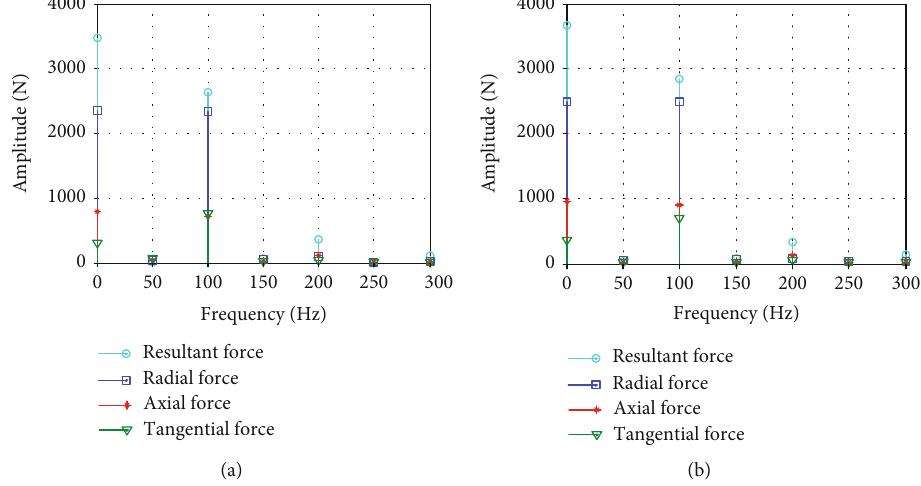
Figure 5: Force spectrum on coil 34: (a) normal condition and (b) eccentricity